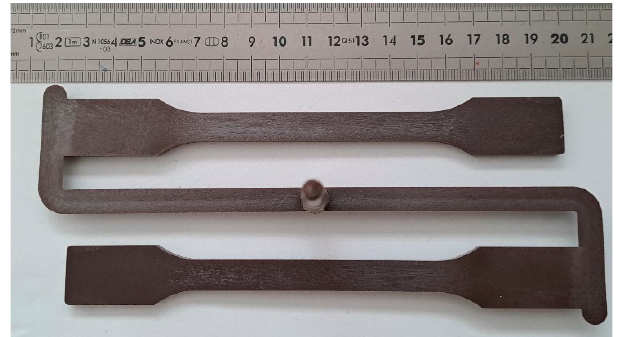
Figure 2 . specimens derived by injection molding (reported composition is of PLA_CSS) . Figure 2. Specimens derived by injection molding (reported composition is of PLA_CSS).